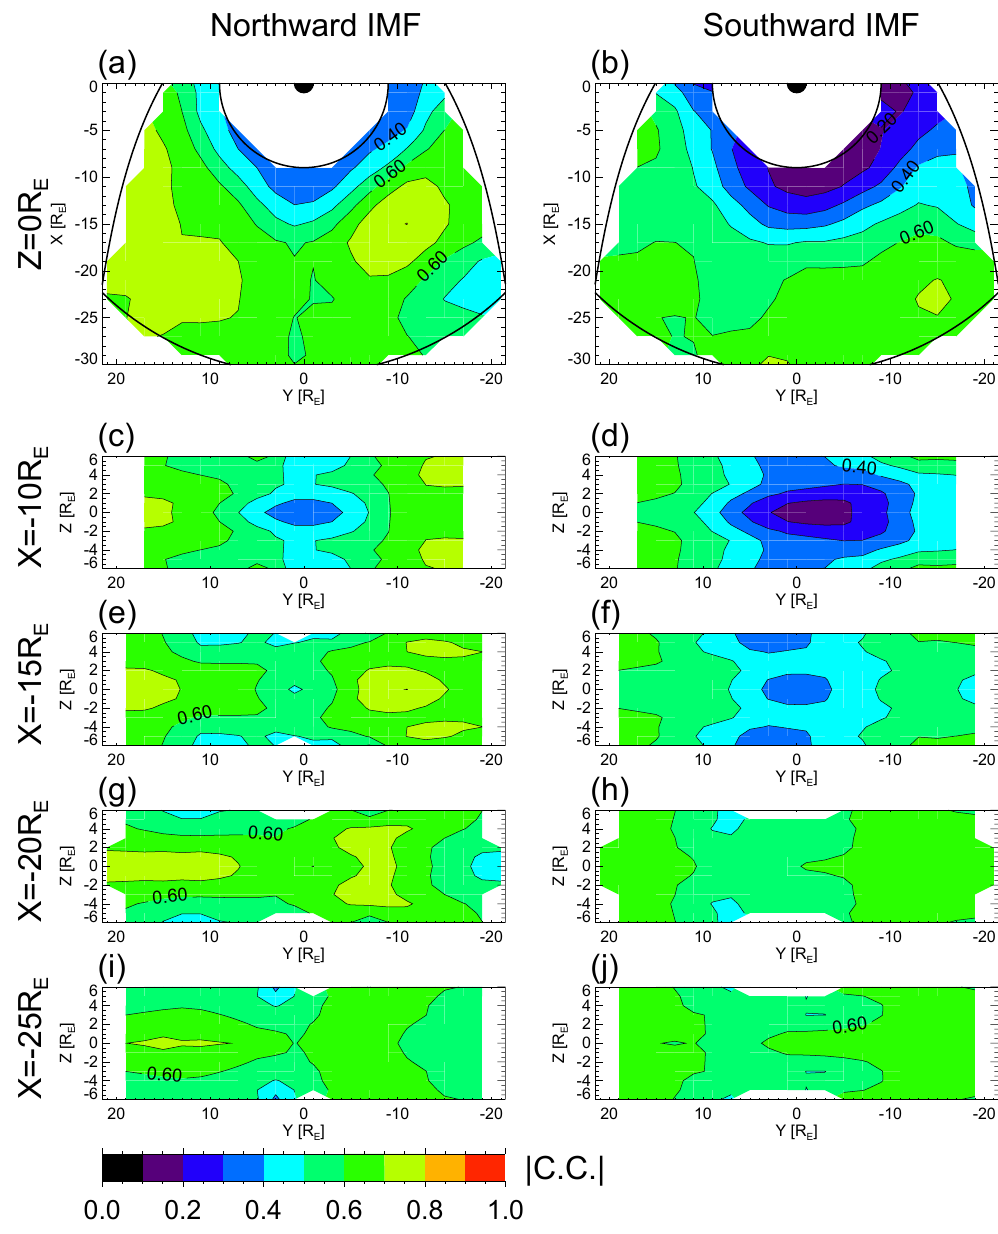
Fig. 10. Distribution of absolute value of correlation coefficient of the fit. Format is the same as Fig. 1.